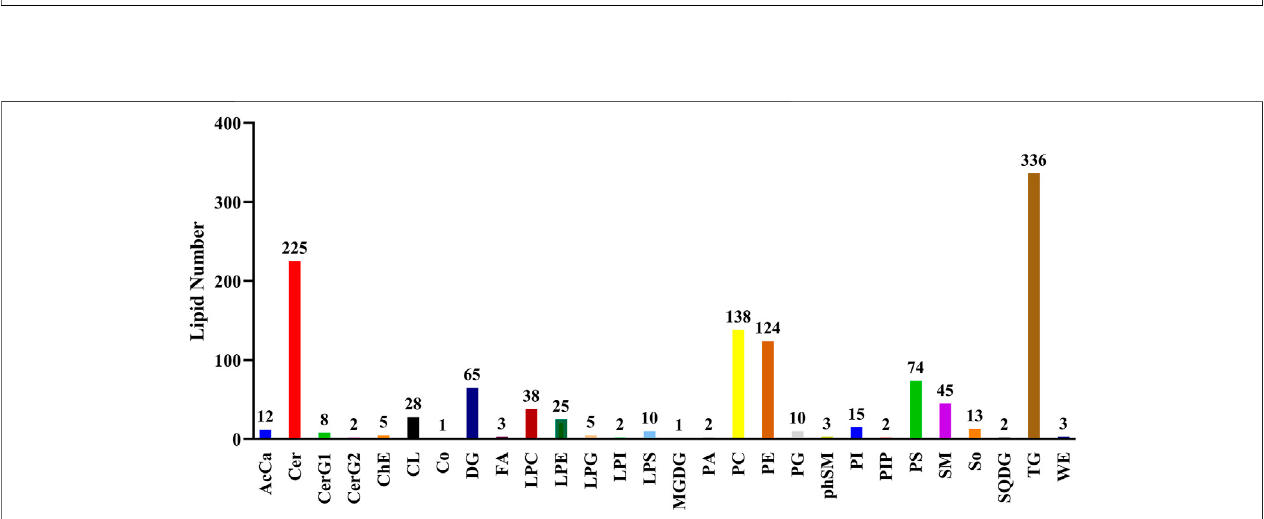
FIGURE 5 | The number of lipid species within each identi fi ed lipid class based on. the International Lipid Classi fi cation and Nomenclature Committee.